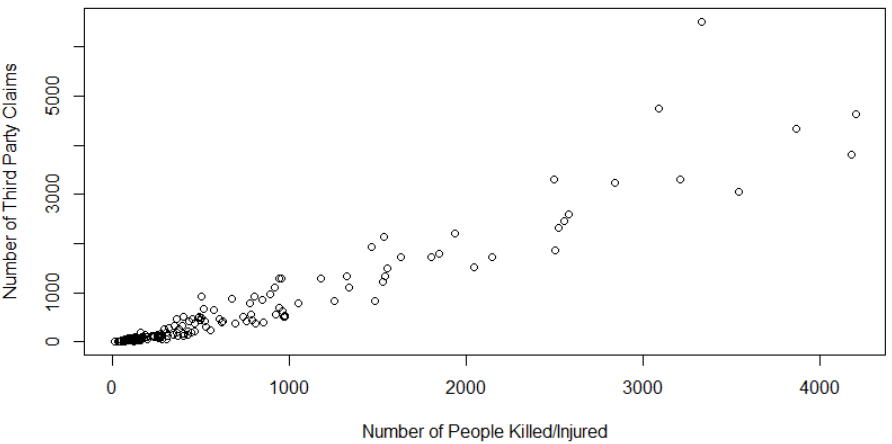
Figure 5. Scatterplot of the Model 4